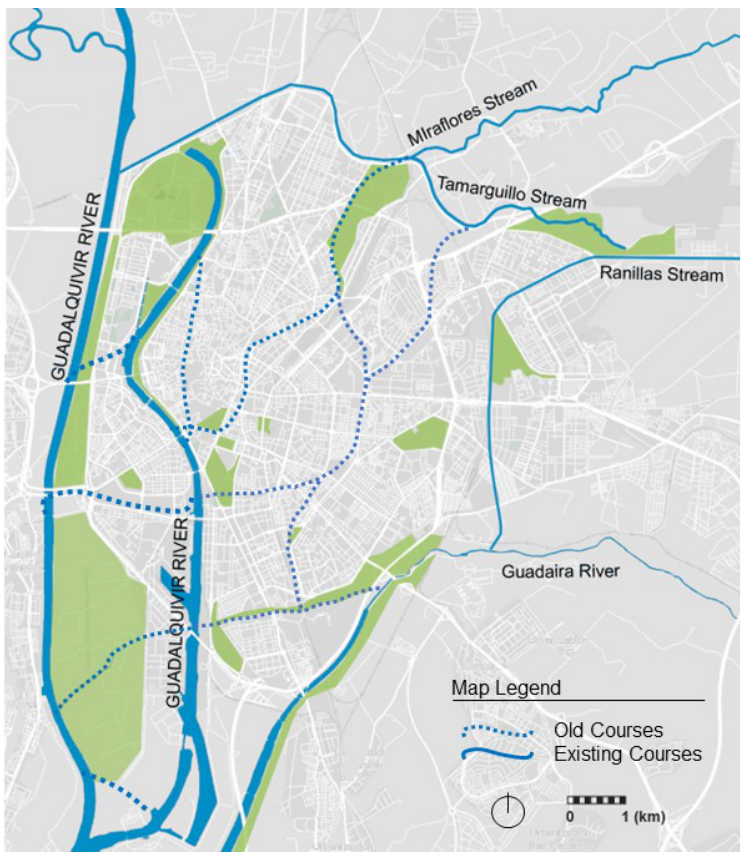
Figure 2. The Guadalquivir River and its tributaries as they pass through Seville and the modifications to their courses. Source: author’s elaboration.